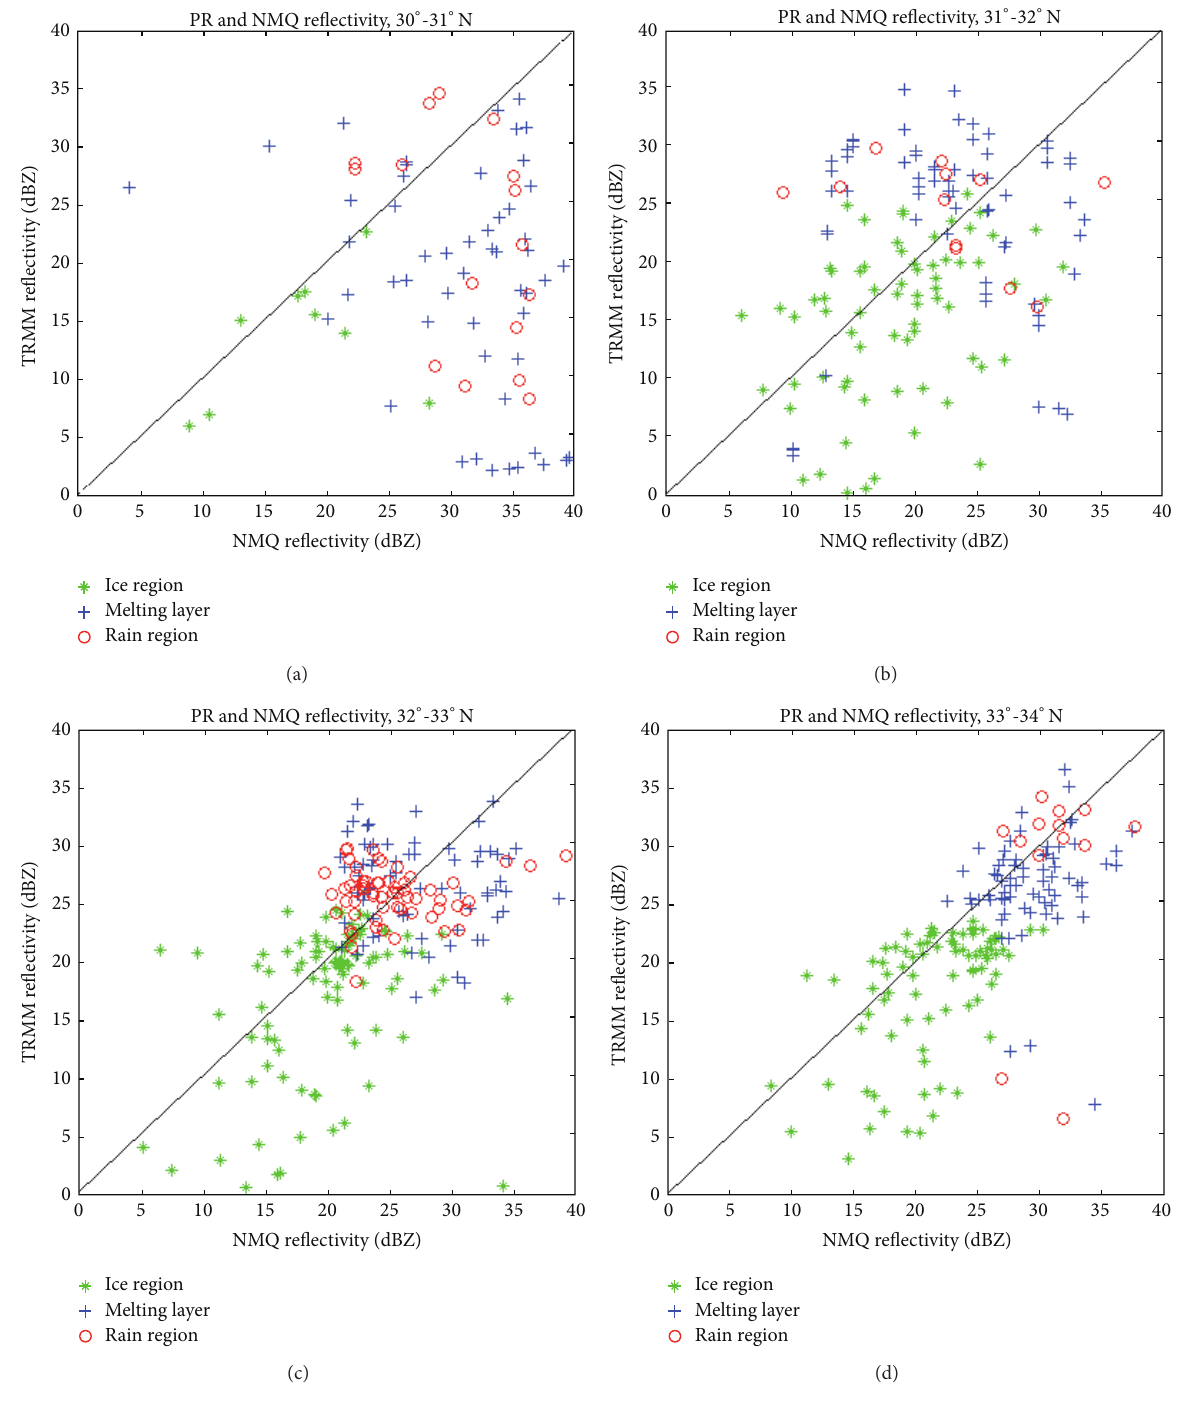
Figure 10: Scatterplots of NMQ reflectivity values and PR reflectivity values from (a) 30 ∘ -31 ∘ N, (b) 31 ∘ -32 ∘ N, (c) 32 ∘ -33 ∘ N, and (d) 33 ∘ -34 ∘ N. The diamonds indicate the ice region, the crosses indicate the melting layer, and the circles indicate the rain region.